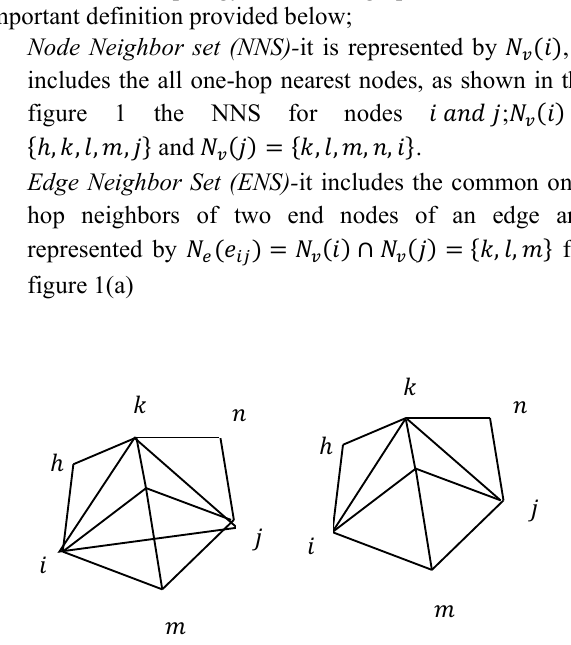
Figure 1. Original graph (a) and triangulated subgraph (b) using the set nodes and edges of WSN